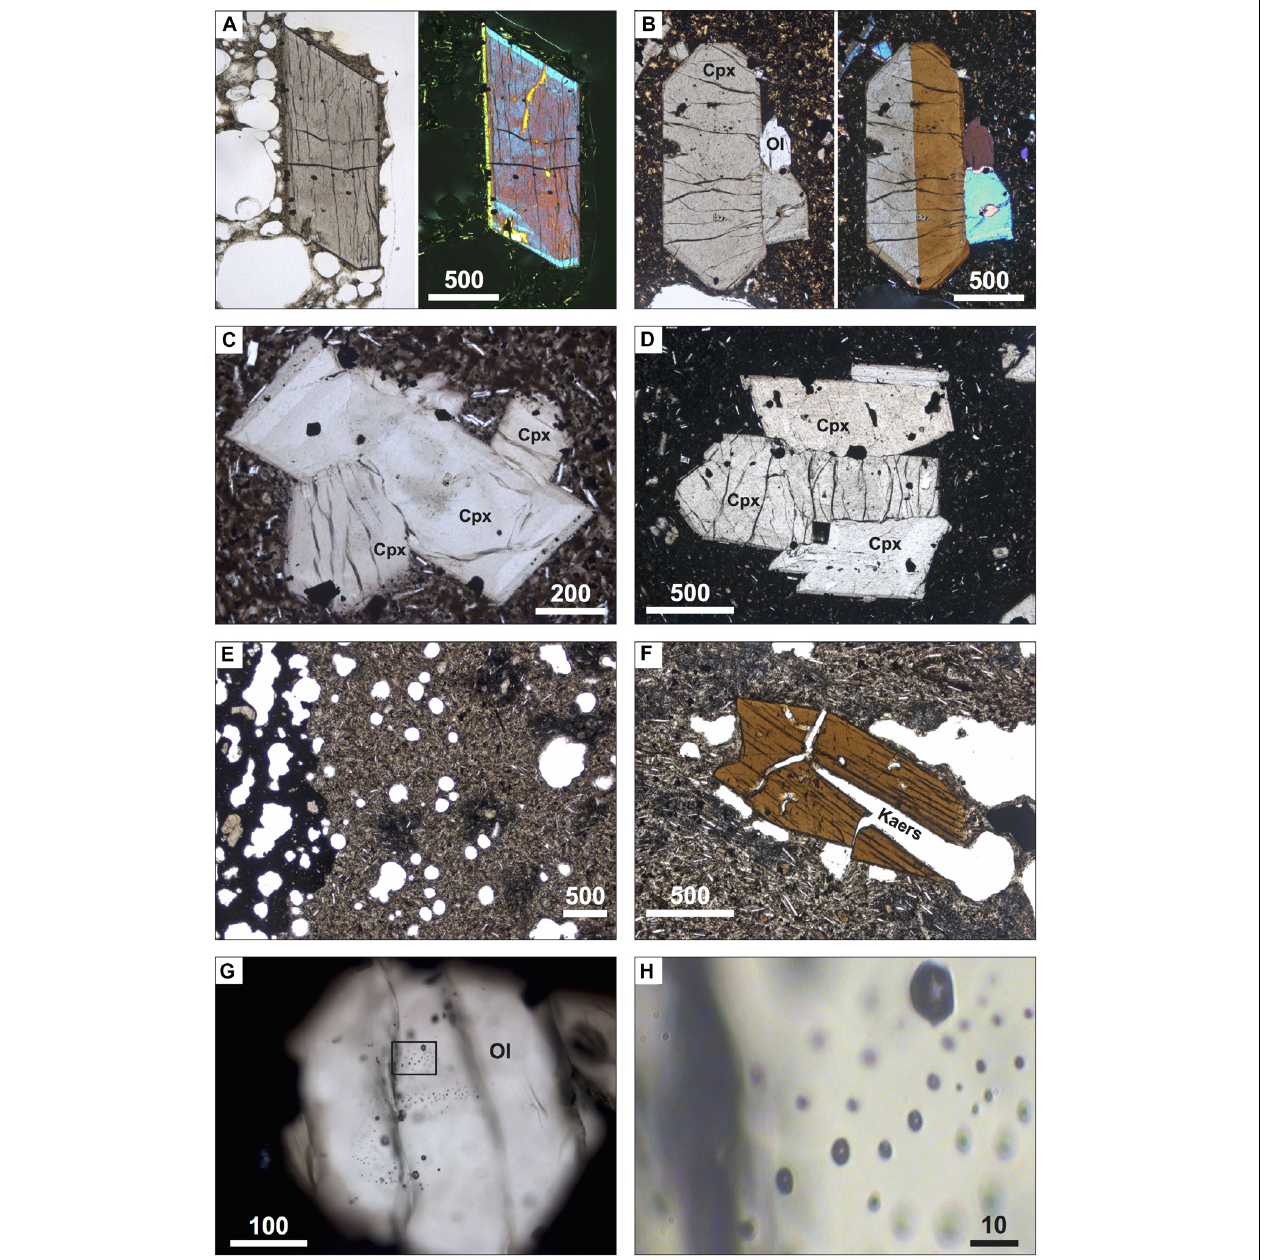
FIGURE 2 | Microphotographs from selected samples taken at plane polarized light [right parts of panels (A,B) ] with crossed polarizers). Scale bars are in micrometers. (A) Euhedral clinopyroxene phenocryst with patchy core zonation and distinct rim zone (sample SD04 Cpx6). (B) Crystal aggregate with euhedral clinopyroxene and olivine (sample SD19 Cpx9). (C) Crystal aggregate of intergrown euhedral clinopyroxenes with complex zonations, interpreted as fragment from crystal mush (sample SD16 Cpx15). (D) Clinopyroxene aggregate interpreted as fragment from crystal mush (sample SD16). (E) Vesicular phonotephrite with basanite rind (left) and dark patches of “K-rich foidite” (sample SD08). (F) Kaersutite phenocryst with thin opacite rim in phonotephrite (sample SD08). (G) Trails of secondary CO 2 -dominated fluid inclusions in clinopyroxene (sample SD13). (H) Detail of area outlined in panel (G) .